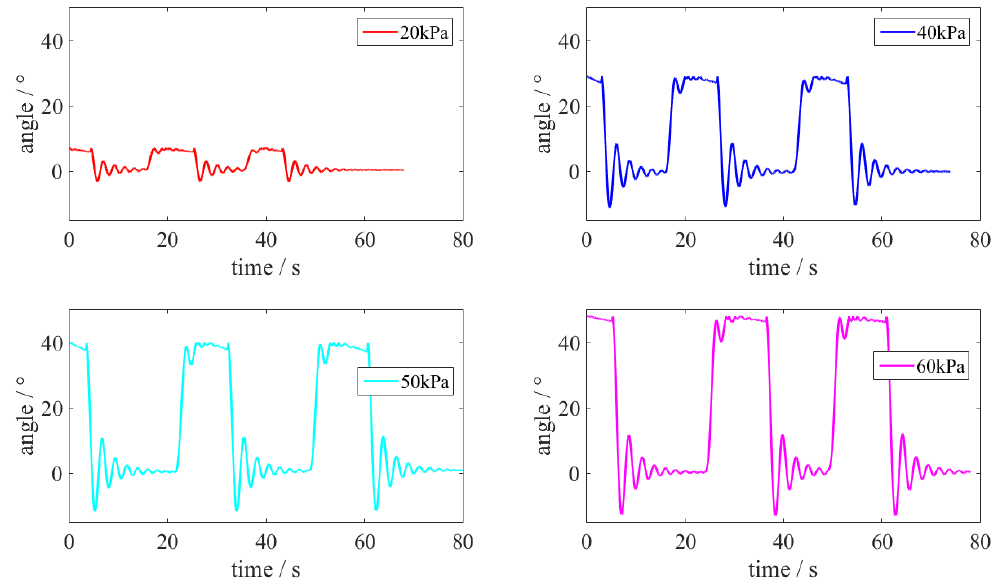
Figure 10. Real-time bending amplitude with various air